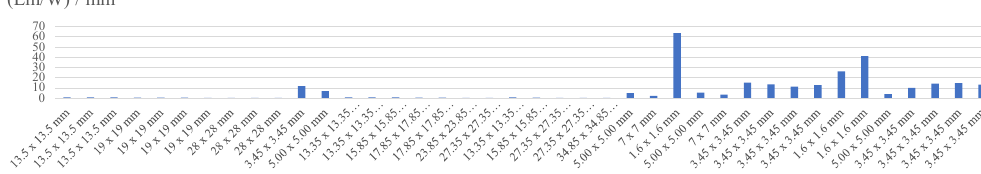
Figure 3. Cree LED manufacturer different LED chip comparison in terms of efficiency (Lm/W per its size in mm 2 ), data obtained at the end of 2020